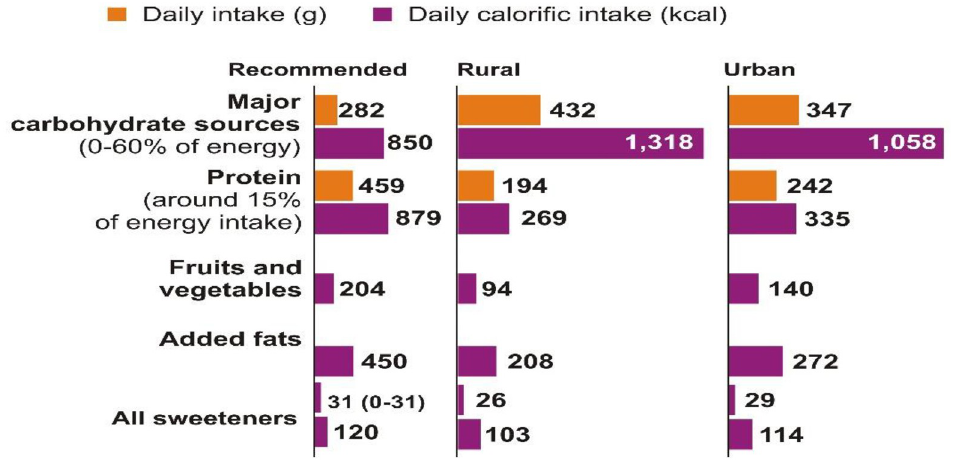
Fig 1. Daily calorie intake. Source: [7]. � Quantities not mentioned for some categories as data for some individual components was in terms of number of packets/cups etc.